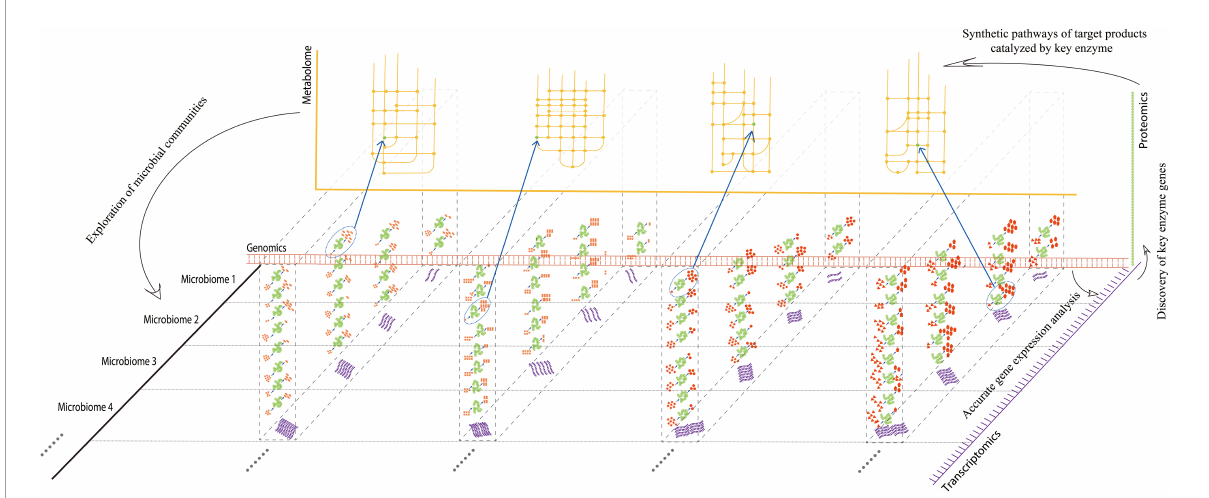
FIGURE1 Advantages of multi-omics analysis at multi-dimensions. Red double-chain structures indicated “genomics,” while purple single-chain structures indicated “transcriptomics,” originating from different microorganisms split by a horizontal dotted line. In each microbiome, the transcription level of the corresponding gene may be different. Proteins or enzymes (green) translated by RNA at different transcriptional levels may have different activities, catalyzing different substrates for products (red). The bottom left corner of each enzyme indicated the substrate, and the top right-hand corner indicated the product. The numbers of substrates and products indicated different catalytic activities for each enzyme. The enzymes with the highest activities, which participated in the corresponding pathways, were circled by dotted ellipses. Synthetic pathways (yellow) of target products can be analyzed by key enzymes discovered at the metabolic level. Exploration of microbial communities can be achieved by each omic from every dimension.